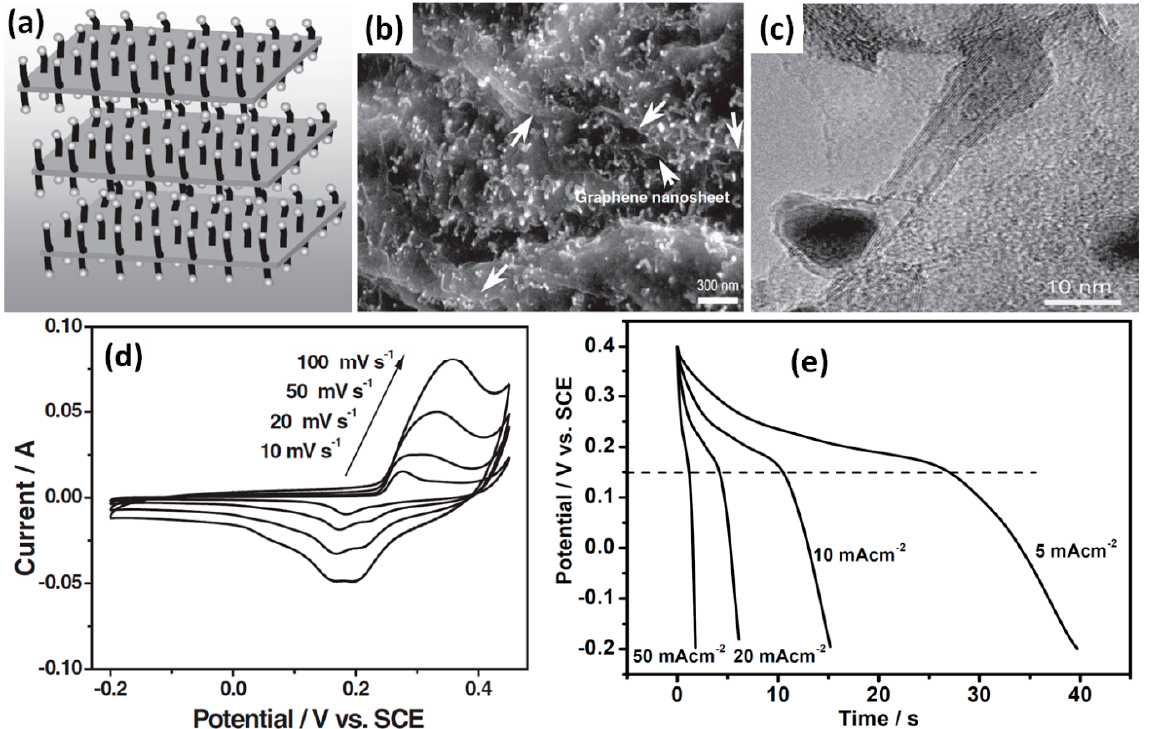
Figure 17. Illustration of the formation of hybrid materials with CNT grown in between graphene nanosheets, showing stacked layers of graphene oxide with Co catalyst particles adhered onto the layer surface after deposition (white points) and CNT in between graphene layers after growth (black tubes) ( a ). SEM images ( b ) and transmission electron microscopy (TEM) image of Co-rGO-CNT ( c ). CV results measured at scan rates of 10, 20, 50, and 100 mV/s ( d ). GCD curves of com- posite electrode at various current densities (5-50 mA/cm 2 ) in KOH solution ( e ) (Reproduced with permission of [45]. Copyright Wiley, 2010).